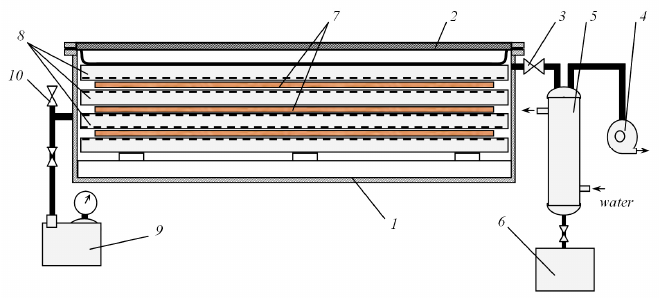
Figure 1. Diagram of the laboratory setup.